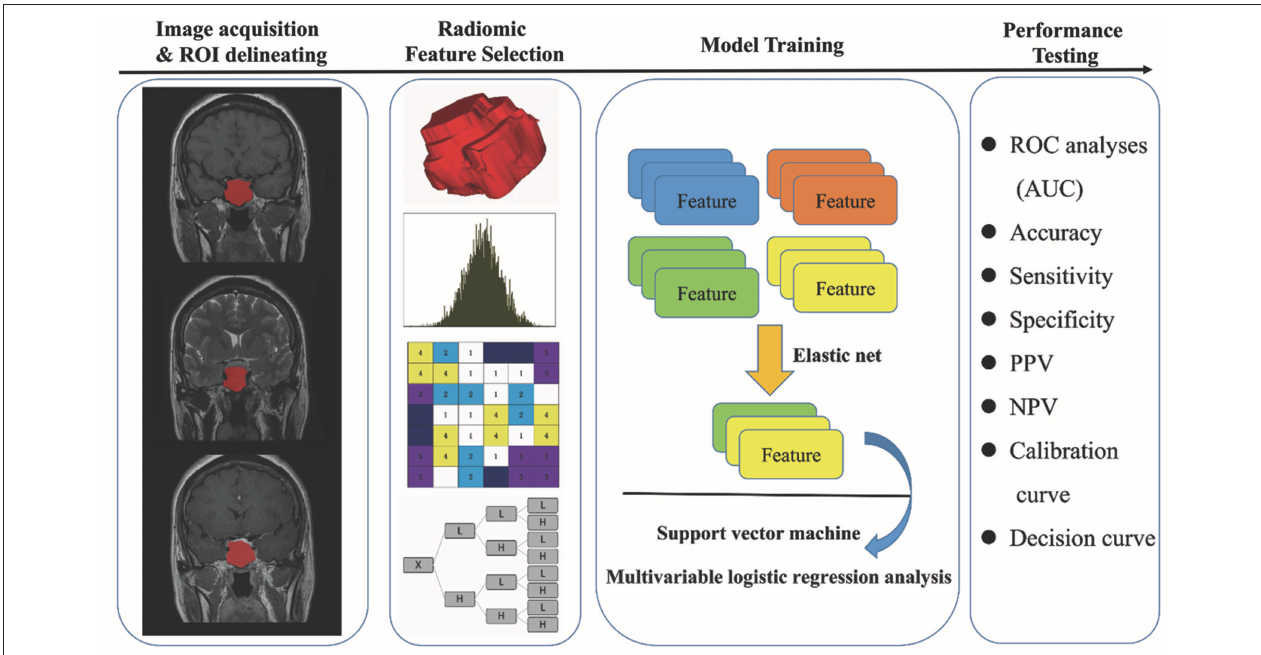
FIGURE 1 | Flow chart of the present study. (I) Original MR image acquisition and ROI segmentation. (II) Radiomics features were extracted from the ROIs, including first-order features, textural features, wavelet features, and shape features. (III) Feature selection and model training. (IV) Performance testing of the model (ROC analysis, calibration curve analysis, decision curve analysis, and multicenter prospective validation). Soft and firm consistency were classified according to the neurosurgeon’s evaluation: a tumor that could be suctioned out using an aspirator was considered soft, while a tumor that could not be suctioned out was considered